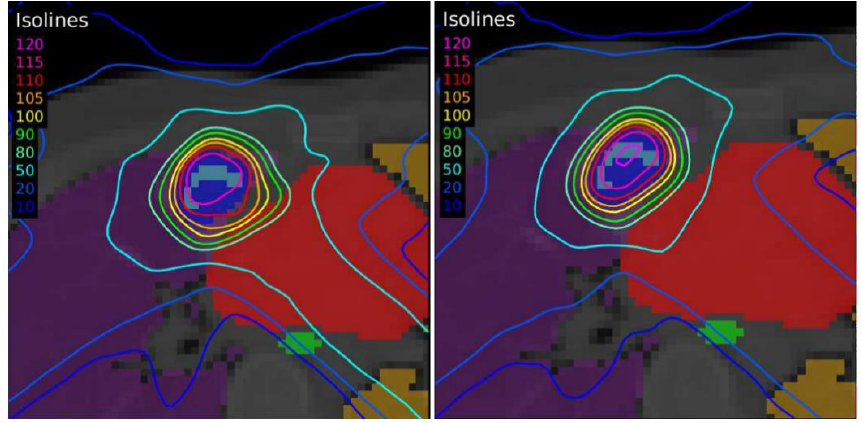
Figure 7. Dose distribution for Case 2 by applying the dose-painting technique under EARL1 ( left )